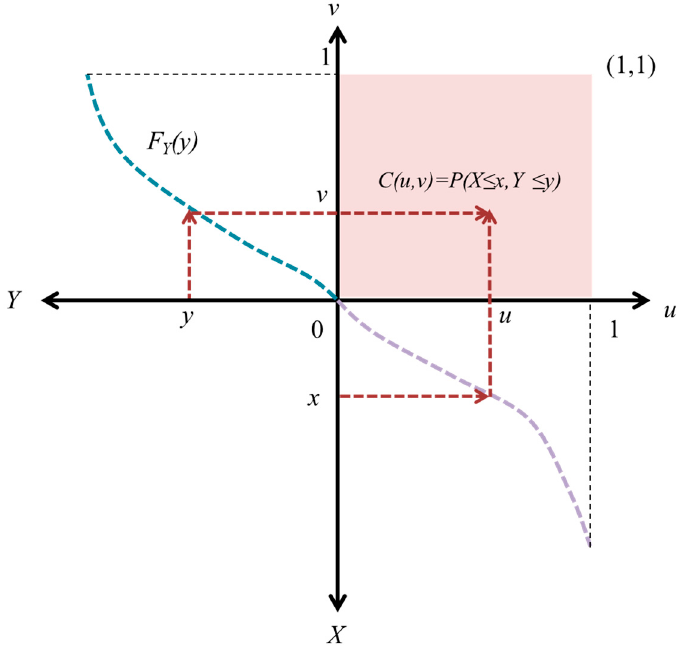
Figure 3. Schematic diagram of the concepts of copula.